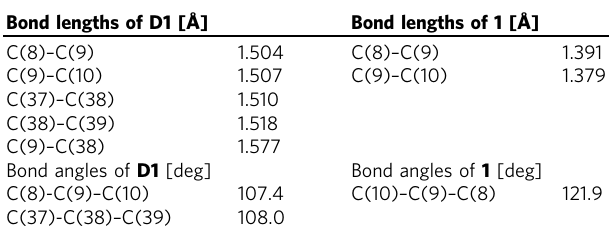
Table 1 Selected bond lengths and angles for [D1] and [1] Bond lengths of D1